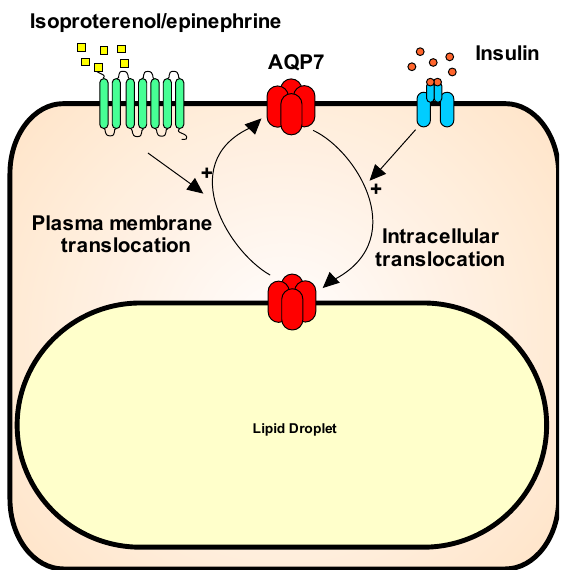
Figure 1. Schematic illustration of the proposed trafficking of AQP7 in adipocytes. Isoproterenol and epinephrine acting likely through beta-adrenergic receptors promotes trafficking of AQP7 from the lipid droplet to the plasma membrane. The opposite translocation occurs in response to insulin stimulation.